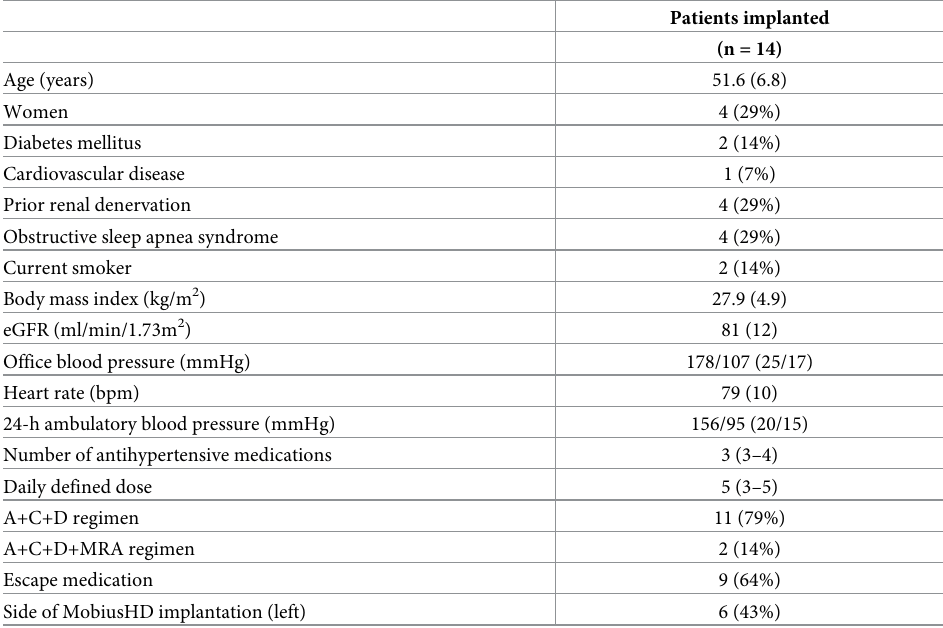
Table 1. Baseline characteristics of all implanted patients.